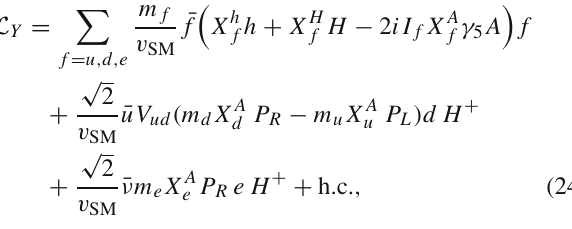
√ means non-zero a f or b